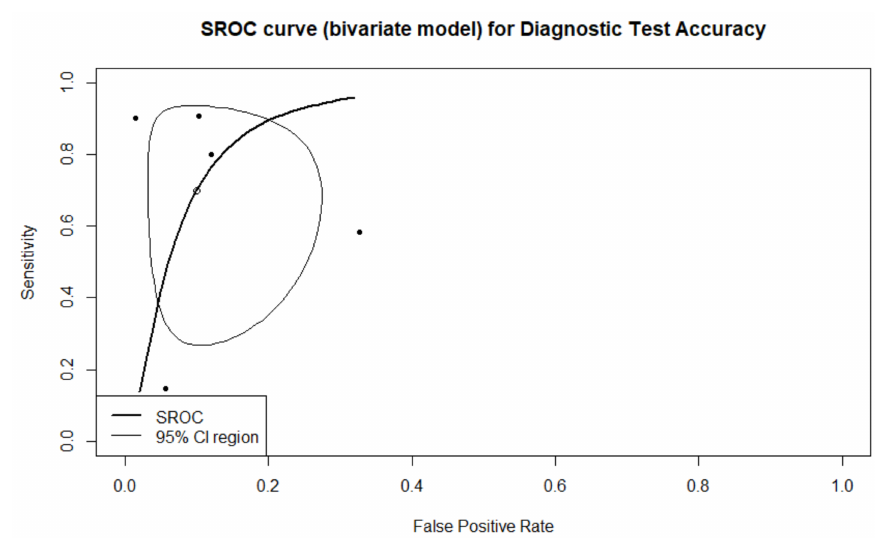
Figure 3. SROC of the live birth